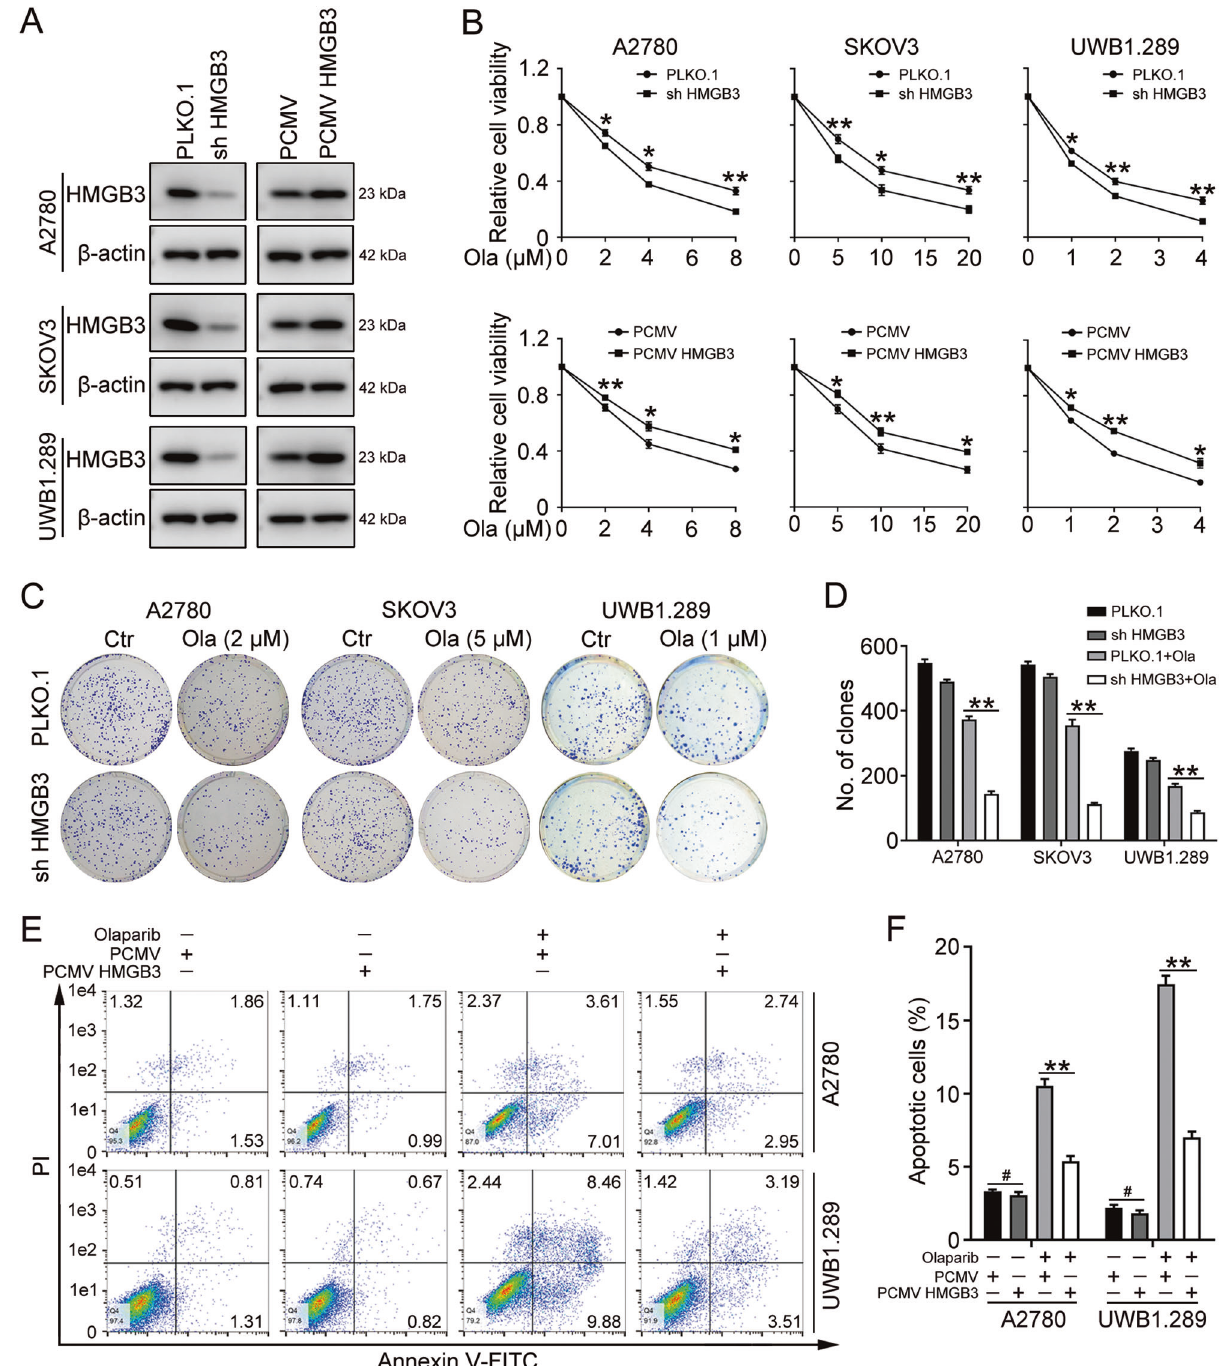
Fig. 2 HMGB3 promotes olaparib resistance in ovarian cancer. A PLKO.1, HMGB3 shRNA (shHMGB3), PCMV, and PCMV HMGB3 plasmids were stably transfected into A2780, SKOV3, and UWB1.289 cells. Western blot was used to determine HMGB3 protein levels. Quanti fi cation of HMGB3 protein levels can be found in Fig. S2. B The MTT assay was performed to detect cell viability in A2780, SKOV3, and UWB1.289 cells treated with olaparib (Ola) for 72 h. C Clonogenic assay was conducted to assess the colony formation ef fi ciency of A2780, SKOV3, and UWB1.289 cells in the presence of olaparib for 7 – 14 days. D Quanti fi cation of the number of clones in ( C ). E Flow cytometry assay was performed to detect cell apoptosis in A2780 and UWB1.289 cells treated with olaparib (A2780, 4 µM; UWB1.289, 2 µM) for 72 h. F Quanti fi cation of the proportion of apoptotic cells in ( E ). (Data are presented as the mean ± SEM, # p > 0.05, * p < 0.05, ** p < 0.01, n =